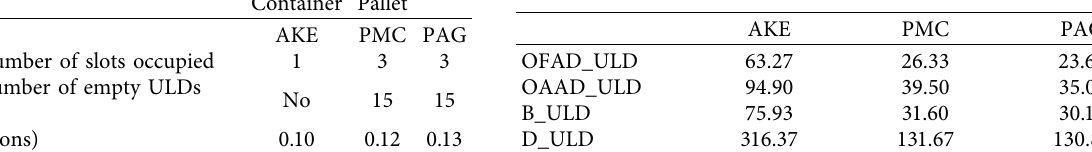
Table 3: Average costs of redispatch methods (US$ per